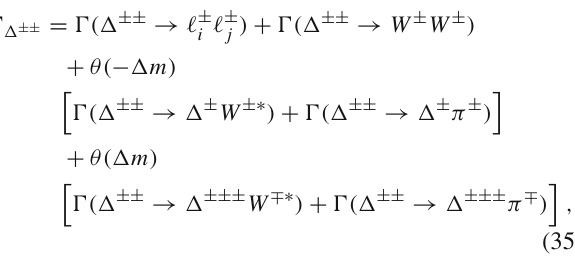
where U is the Pontecorvo-Maki-Nakagawa-Sakata (PMNS) mixing matrix. Assuming that the CPV phases in the PMNS matrix are zero, we can determine the explicit form of m ν angles and neutrino mass squared differences for both normal hierarchy (NH) and inverted hierarchy (IH) mass